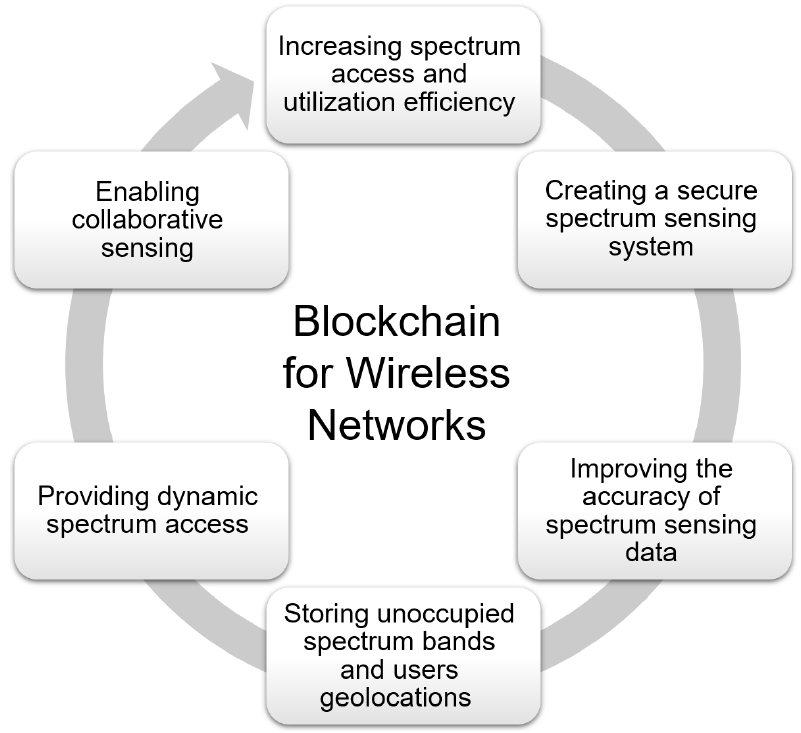
Figure 6. Blockchain for wireless